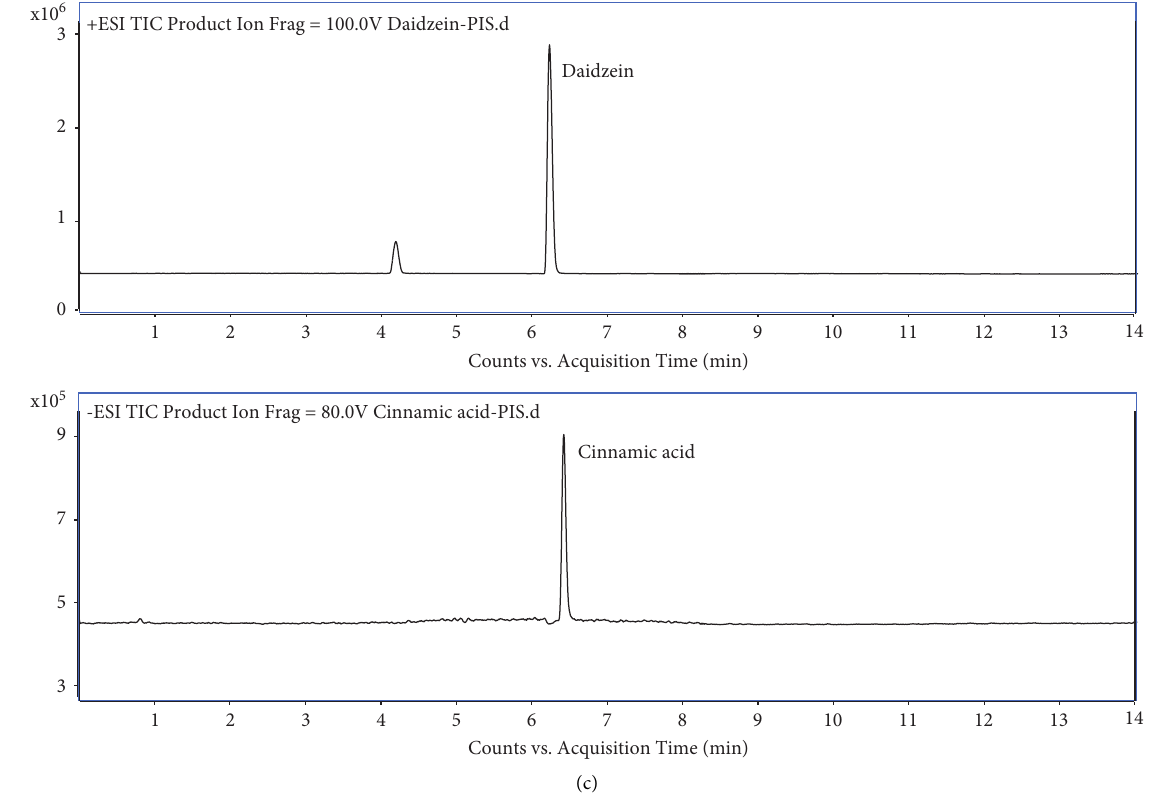
Figure 2: UHPLC-QQQ-MS/MS extracted ion chromatograms of 10 investigated